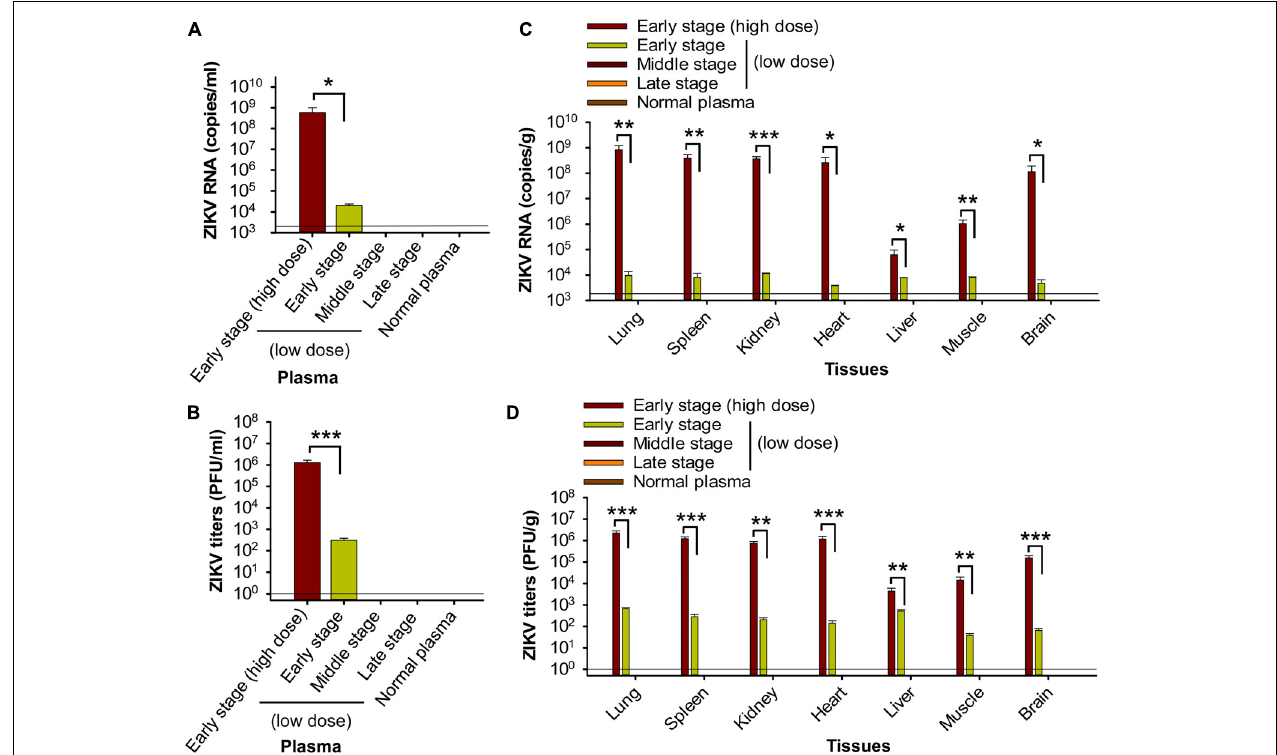
FIGURE 2 | Transfusion of pregnant A129 mice with early-stage (high dose) ZIKV + plasma resulted in significant viremia and broad tissue tropism. Pregnant (E10–12) A129 mice were transfused with ZIKV + plasma from early, middle, and late stages, respectively, and plasma and tissues were collected 6 days post-transfusion for below tests. Plasma ZIKV RNA (A) and ZIKV titers (B) were detected by qRT-PCR and plaque assay, respectively. Tissue ZIKV RNA (C) and viral titers (D) were detected by qRT-PCR and plaque assay, respectively. ∗ , ∗∗ , and ∗∗∗ indicate significant differences between early stage (high dose) and early stage (low dose) post-transfusion with ZIKV + plasma. The data are presented as means ± s.e.m ( n = 6 mice/group). In (A) and (C) , the limit of detection, shown as the horizontal lines, was about 2.5 × 10 3 copies/ml (for A ) or 2.5 × 10 3 copies/g (for C ) of ZIKV RNA. This was determined based on a detection limit of 10 2 copies in a linear standard curve (at serial dilutions of 10 2 to 10 10 copies) of ZIKV RNA, as described in Materials and Methods. In (B) and (D) , the detection limit was about 1 PFU/ml (for B ) or 1 PFU/g (for D ). The experiments were repeated twice, and similar results were obtained. Normal plasma: control plasma from A129 mice transfused with normal plasma without